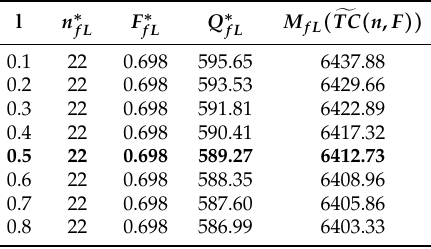
Table 7. Effect of l on the fuzzy-learning